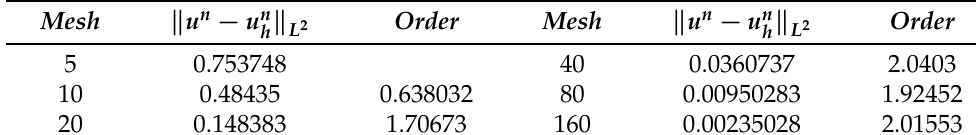
Figure 1. The behavior of the error (cid:107) u n − u n Experiment